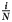
The X axis is the strength of incentive T, and the Y axis is the evolutionary stability strategy of iN.dx.doi.org/10.17504/protocols.io.bgbfjsjn.